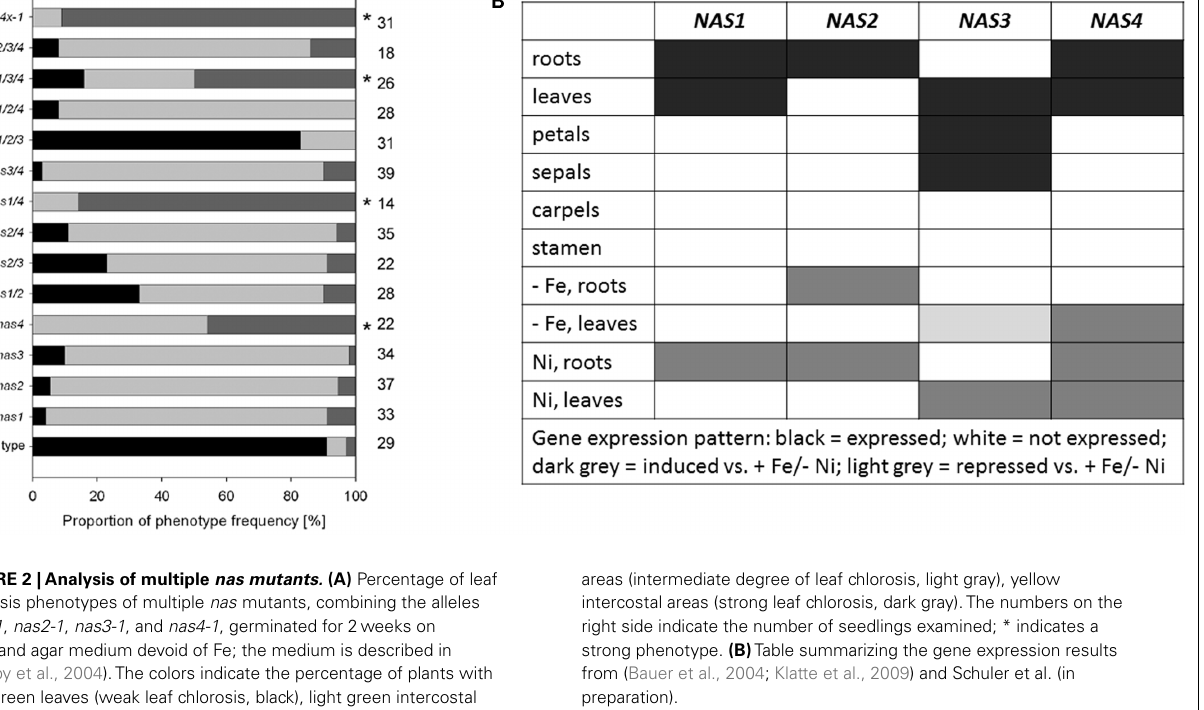
areas (intermediate degree of leaf chlorosis, light gray), yellow intercostal areas (strong leaf chlorosis, dark gray).The numbers on the right side indicate the number of seedlings examined; * indicates a strong phenotype. (B) Table summarizing the gene expression results from (Bauer et al., 2004; Klatte et al., 2009) and Schuler et al. (in preparation).